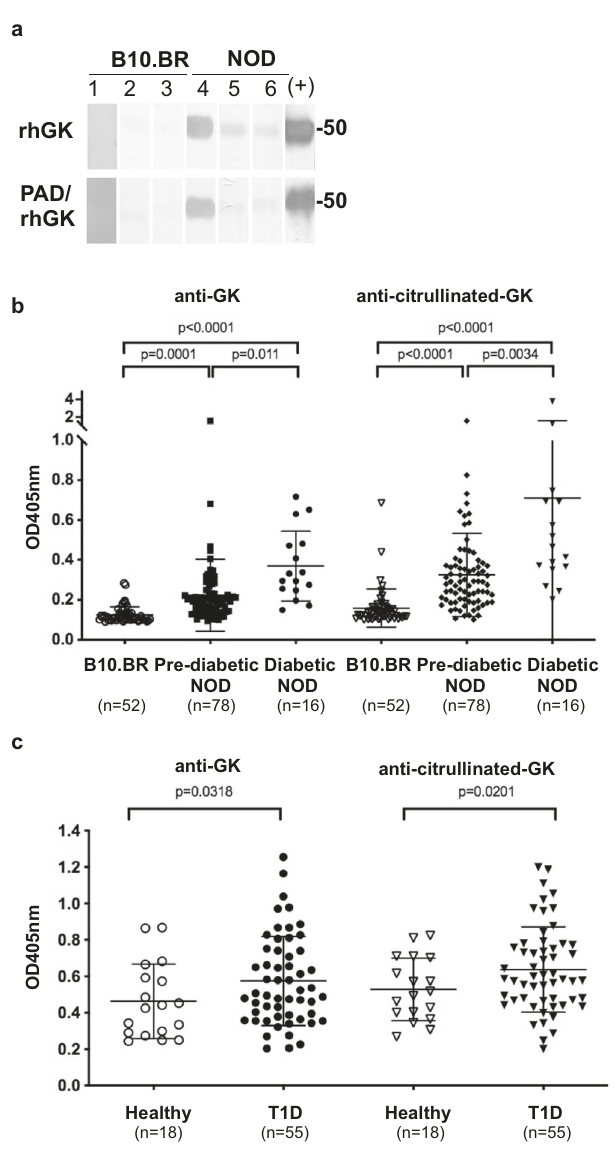
Fig. 2 The prevalence of autoantibodies against glucokinase and citrullinated glucokinase in both murine and human models of T1D. a rhGK and PAD-rhGK (1 µ g per lane) were subjected to electrophoresis and followed by immunoblot with rabbit anti-GK as positive control ( + ) and sera from 16-week-old B10.BR and NOD mice, respectively (lanes 1 – 6). b – c The serum levels of anti-GK and anti-citrullinated GK from NOD mice and control mice ( b ) and from patients with T1D and healthy subjects ( c ) were measured by ELISA (as described in Methods). The number of samples analyzed is indicated at the bottom of each group and the error bars indicated SD of mean. Statistical analysis was performed using Student ’ s t -test. CD4 + T cells speci fi c for citrullinated GK epitopes in the